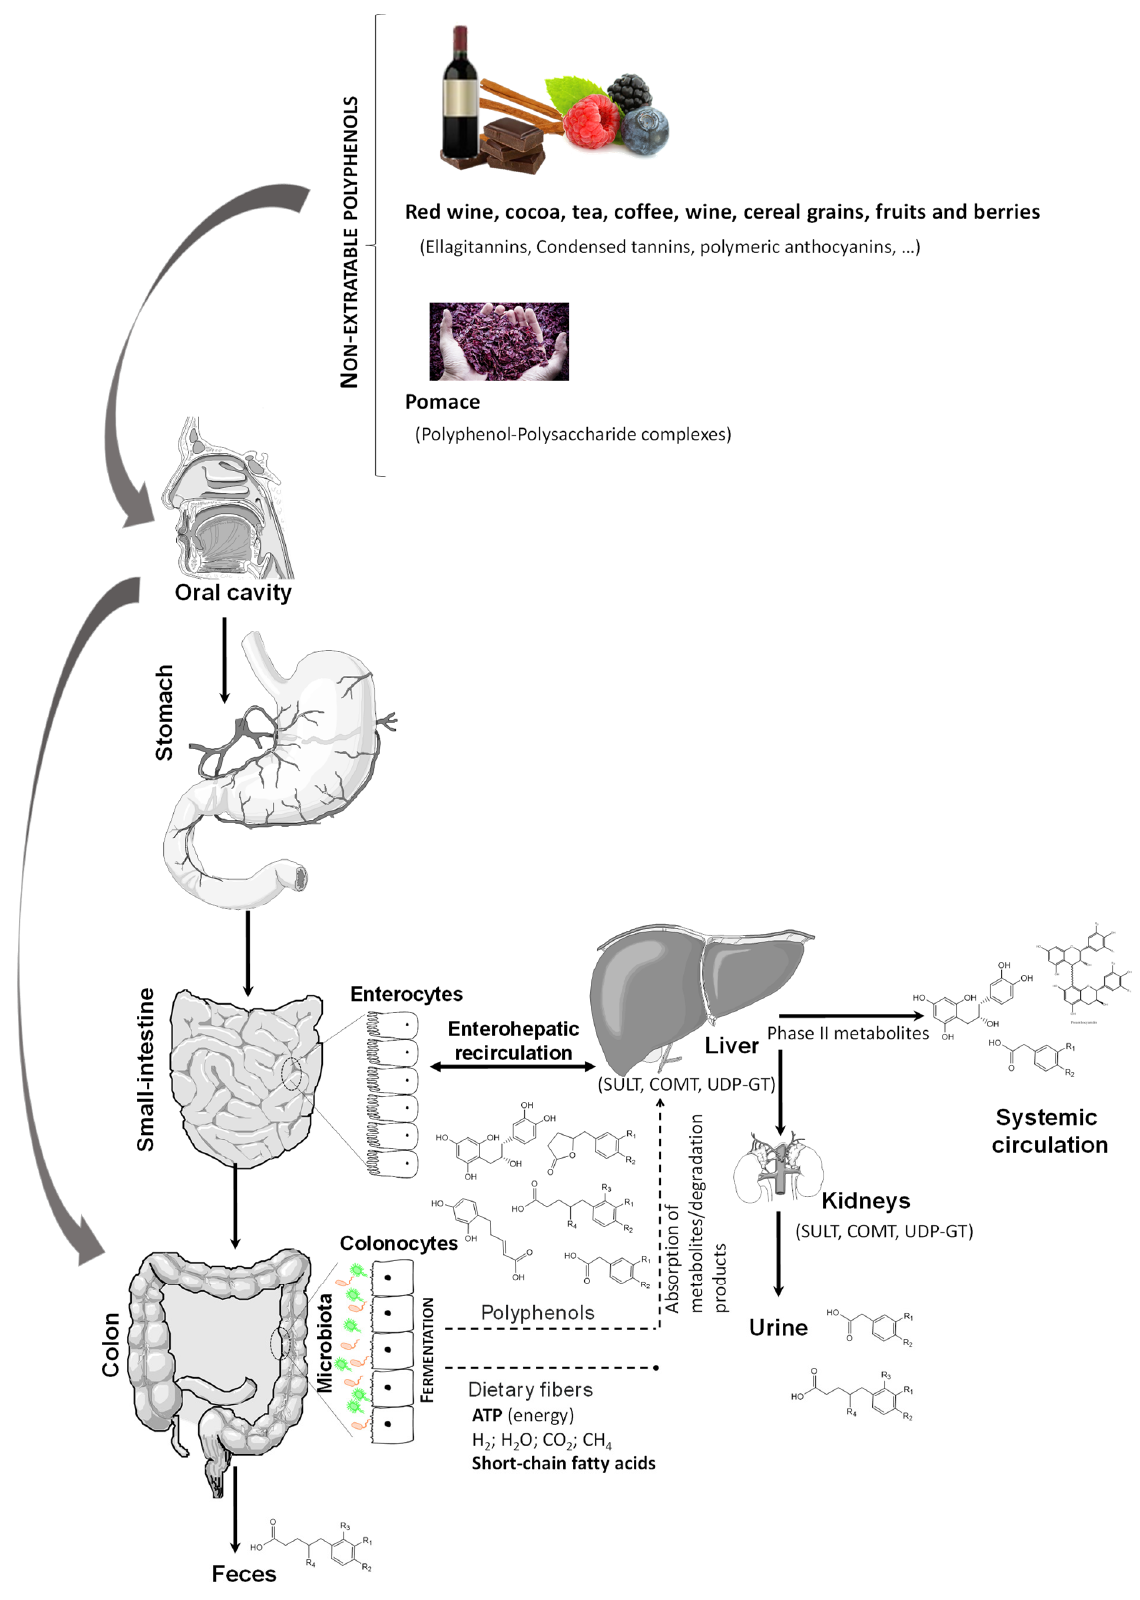
Figure 3. Oral ingestion and gut microbiota catabolism of non-extractable polyphenols. SULT: Sulfotransferases; UDP-GT: Uridine 5 ′ -diphospho-glucuronosyltransferase; COMT: Catechol- O - methyltransferase.